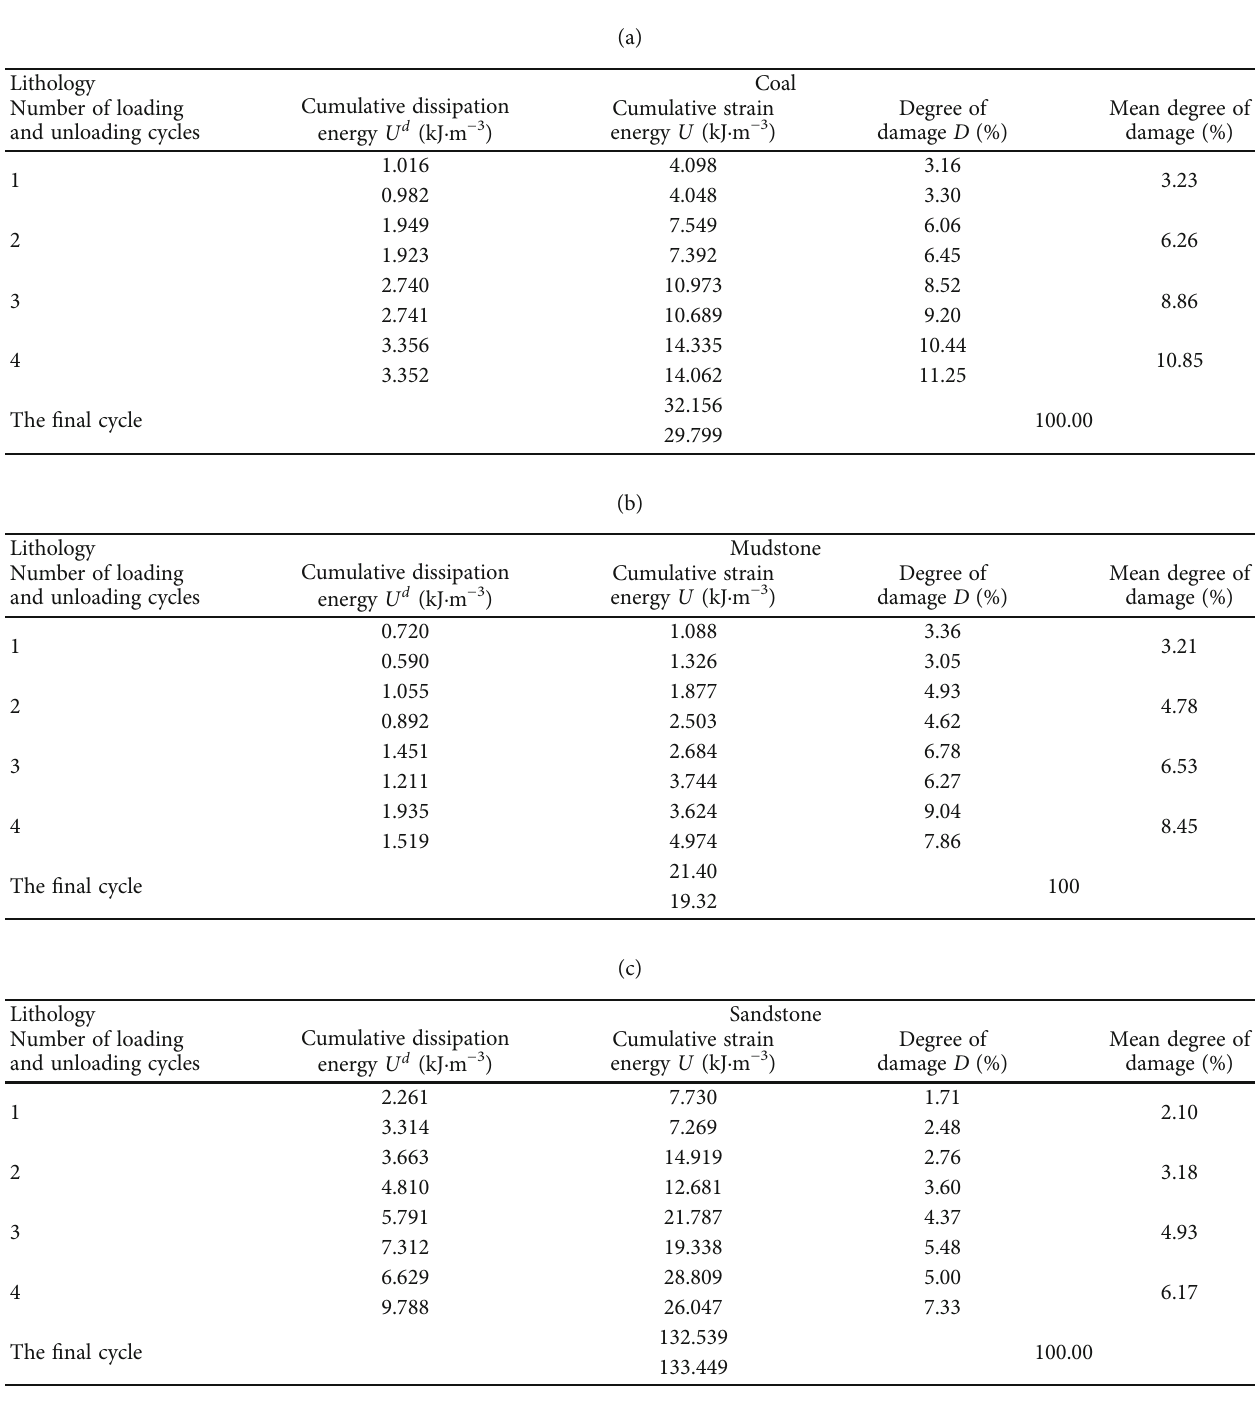
Table 3: Changes of various energy parameters for cycle loading and